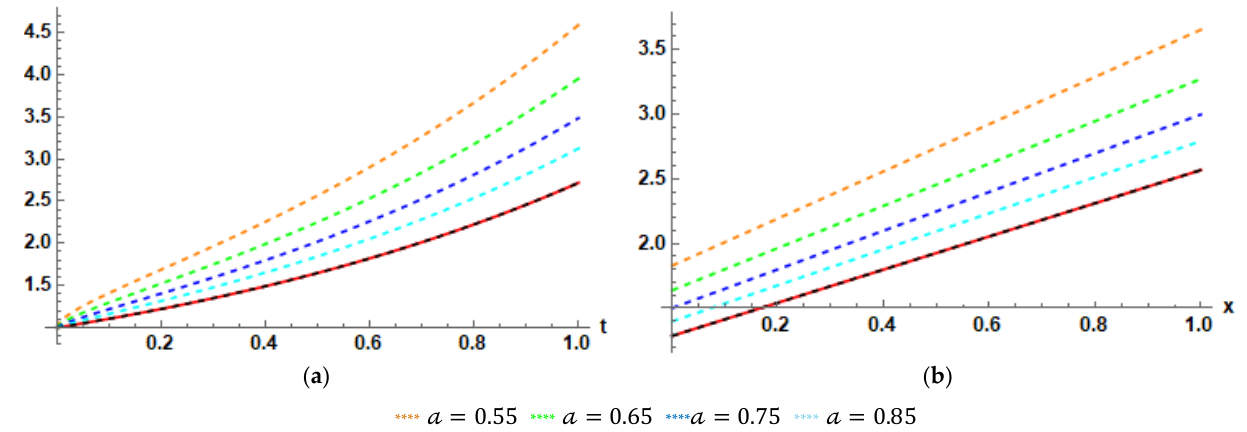
Figure 1. ( a ) Plots of Exact 𝒲(𝑥,𝑡) and 𝒲 (cid:2869)(cid:2868) (𝑥,𝑡) at 𝑥 = 0 and with various 𝒶 values of IVP (7). ( b ) Plots of Exact 𝒲(𝑥,𝑡) and 𝒲 (cid:2869)(cid:2868) (𝑥,𝑡) at 𝑡 = 0 and with various 𝒶 values of IVP (7).